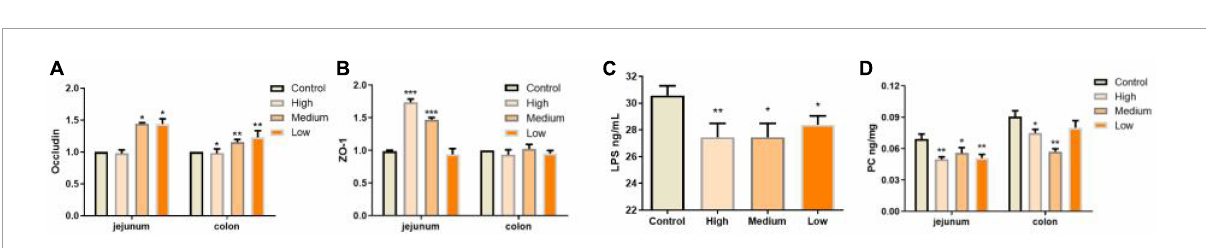
FIGURE5 PSP-NP improves intestinal integrity of aged mice. (A) Gene expressions of tight junction protein Occludin in jejunum were up-regulated in jejunum but down-regulated in colon. N = 8. (B) Gene expressions of ZO-1 in jejunum and colon, which were both up-regulated. N = 8. (C) The LPS contents in serum (ng/mL) were analyzed by ELISA, and it was remarkably decreased after administration of PSP-NP, N = 16. (D) The content of carbonylated proteins (ng/mg) in jejunum and colon was determined by ELISA, and it was statistically reduced by PSP-NP in all the three groups of PSP-NP. Control indicated the control group administrated with saline, and High, Medium and Low indicated the high, medium and low dose groups administrated with 200/100/50 mg/kg PSP-NP, respectively. Error bars indicated SEM. N = 16. All data were analyzed by SPSS with the one-way analysis of variance (ANOVA) by LSD test, * P < 0.05, ** P < 0.01, *** P < 0.001, compared with the control